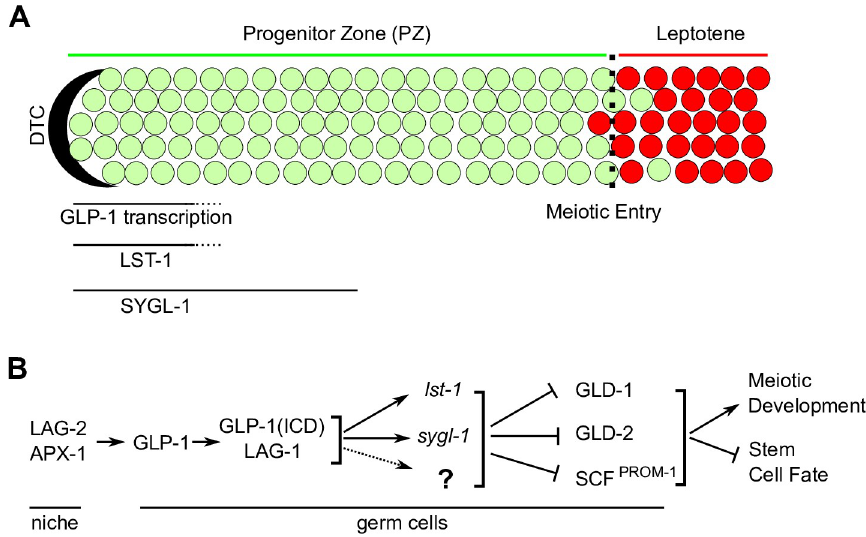
Fig 1. Overview of GLP-1 signaling in the distal germline of C . elegans . (A) Schematic of the adult hermaphrodite distal germline. The distal end of the germline is capped by a somatic distal tip cell (DTC). Progenitor zone cells are shown in green; meiotic prophase cells are in red. Dashed line indicates the progenitor zone–meiotic prophase boundary, the operationally defined point of meiotic entry [4]. GLP-1 signaling maintains germline stem cell fate and GLP-1 mediated transcription occurs in the distal most ~5 cell diameters (cd) of the germline [21,42].LST-1 and SYGL-1 protein are observed in the distal most 5 or 10 cell diameters, respectively [22]. (B) Genetic pathway controlling the stem cell fate vs meiotic development decision in the distal end of C . elegans germline. GLP-1 signaling acts, at least in part, through transcriptional targets lst-1 and sygl-1 to repress the GLD-1, GLD-2 and SCF PROM-1 meiotic entry pathways (reviewed in [4]). GLP-1(ICD), GLP-1 intracellular domain.